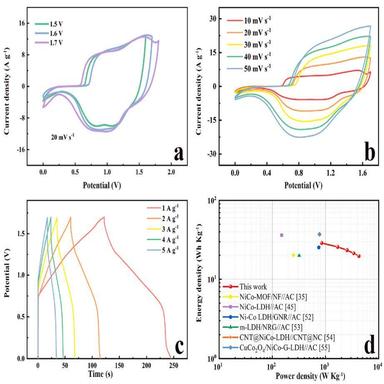
CV curves of N/NC-10//AC ASC device at 20 mV s − 1 (a), CV curves at scan rates from 10 to 50 mV s − 1 (b), GCD curves of N/NC-10//AC ASC device at current densities of 1–5 A g− 1 (c) and Ragone plots of N/NC-10//AC ASC device (d).